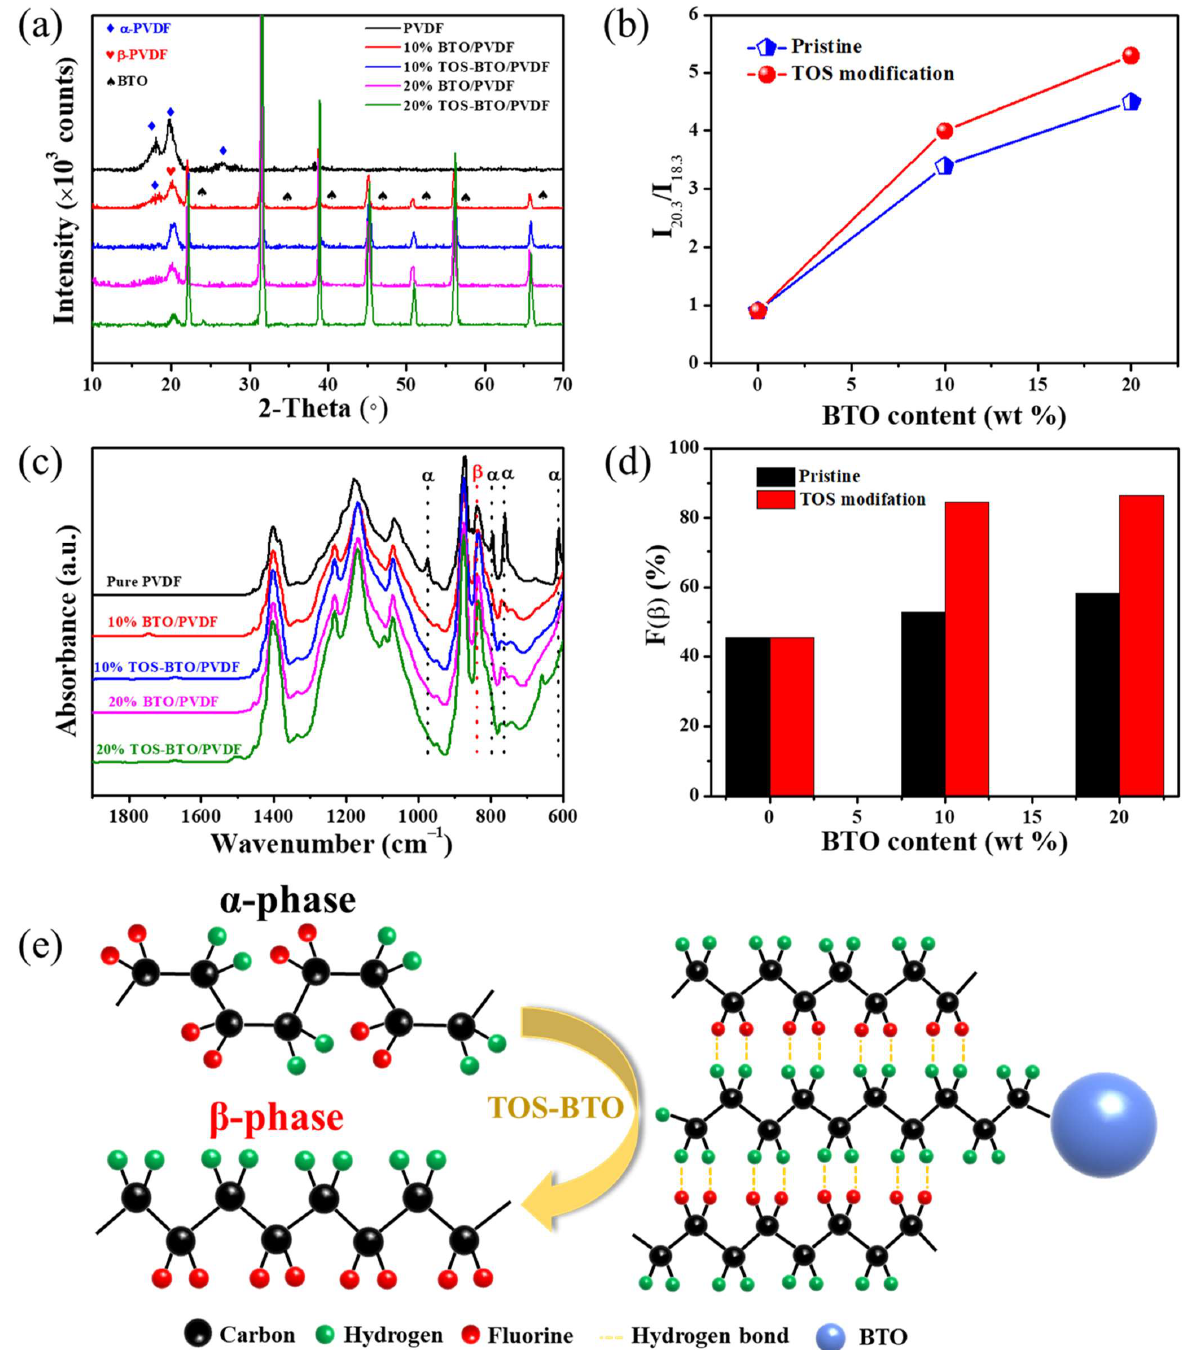
Figure 5. ( a ) XRD spectra of pristine PVDF, BTO/PVDF and TOS-BTO/PVDF film. ( b ) I 20.3 /I 18.3 ratios of the samples calculated from XRD spectra. ( c ) FTIR spectra of pristine PVDF, BTO/PVDF and TOS-BTO/PVDF film. ( d ) Variation in the F(β) value of the as-prepared samples. ( e ) Schematic of phase transformation between TOS-BTO nanoparticles and the PVDF matrix. A quasistatic d 33 meter was used to record the d 33 of the screen-printed nanocompo- sites and investigate their piezoelectric capabilities, as shown in Figure 6a. The d 33 value